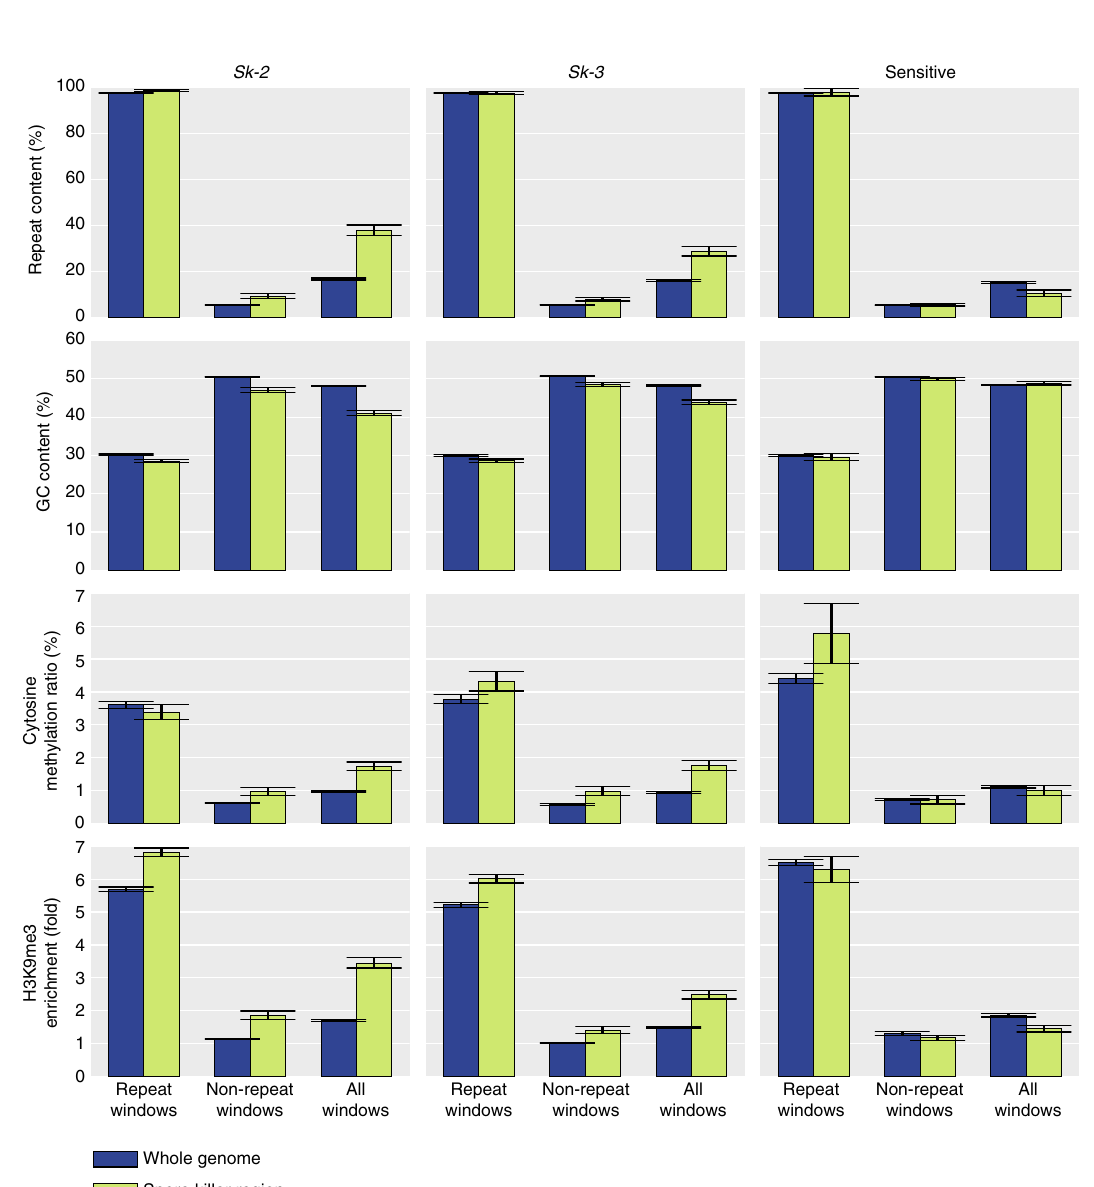
Fig. 3 Repeat content, GC content, cytosine methylation, and H3K9me3 enrichment of the genome and the spore killer region in strains 3194 ( Sk-3 ), 7426 ( Sk-2 ), and 8761 (sensitive) of Neurospora intermedia . All values are calculated using 2 kb sliding windows with a step size of 2 kb. Windows consisting of >75% repetitive content are classi fi ed as “ repeat windows ” and those with <75% are classi fi ed as “ non-repeat windows. ” “ Repeat content ” plots indicate that most windows classi fi ed as repetitive contain close to 100% repeats, consistent with a clustered distribution of repeats. Error bars show 95% con fi dence intervals. GC content, cytosine methylation levels, and H3K9me3 levels are all signi fi cantly different between repeat and non-repeat windows (Student ’ s T test, p ≪ 0.001 for all comparisons). The Sk regions of the spore killers are also signi fi cantly different from the rest of the genome in all these characteristics, though the differences are less pronounced than when comparing repetitive and non-repetitive regions. These results are consistent with previous data from N. crassa , in which cytosine methylation and H3K9me3 histone methylation are both signatures of constitutive heterochromatin and primarily found in repetitive regions that have been mutated by the RIP mechanism, which also lowers the GC